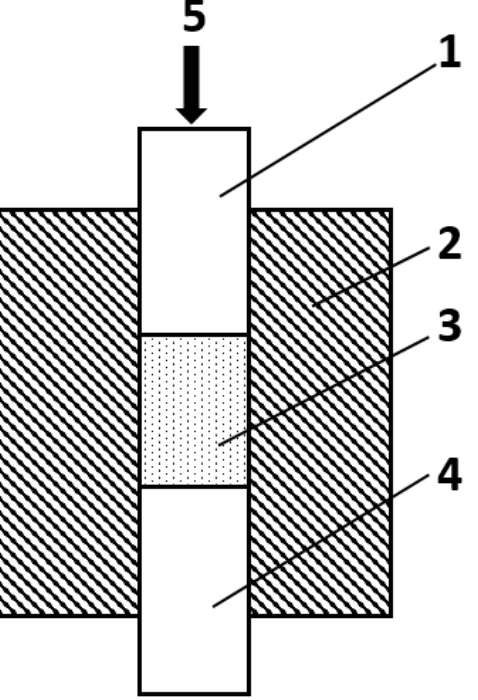
Figure 4. Schematics of magnetic pulse compaction with pressure applied from top: 1—upper punch, 2—matrix, 3—molding mass, 4—bottom punch, 5—mechanical load transferred from the concentrator coupled with the upper punch.